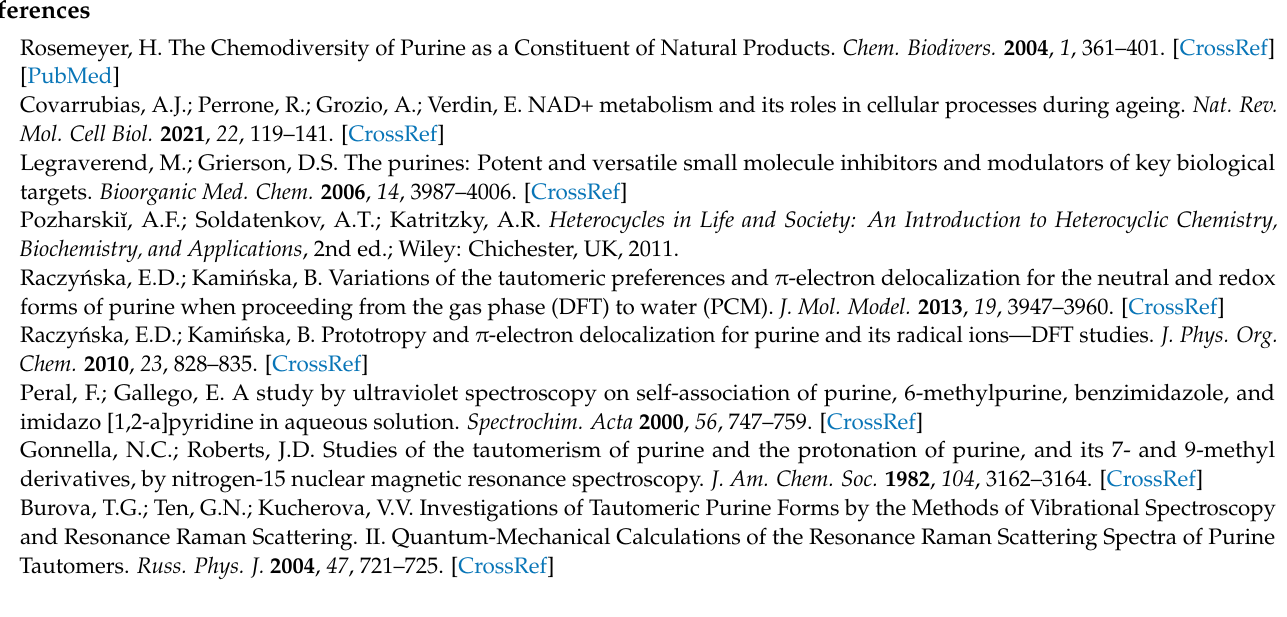
purines. Figure S1: NCI analysis for selected systems. Visualization of reduced density gradient isosurfaces; Figure S2: Change in (a) HOMA and (b) HOMED of 6- and 5-membered rings between the formamide and the gas phase plotted against the HOMA (HOMED) value for the respective ring of aminopurines in the gas phase; Figure S3: Values of HOMED index for 6- and 5-membered rings of C2, C6, C8, and N amino-substituted derivatives of purine in four tautomeric forms, calculated for the gas phase geometry; Figure S4: Changes in HOMED index due to (a) solvation and (b) substitution; Figure S5: Solvation energies of tautomers, E solv , for (a) C2-NH 2 , (b) C6-NH 2 (c) C8-NH 2 (d) N-NH 2 , and (e) unsubstituted